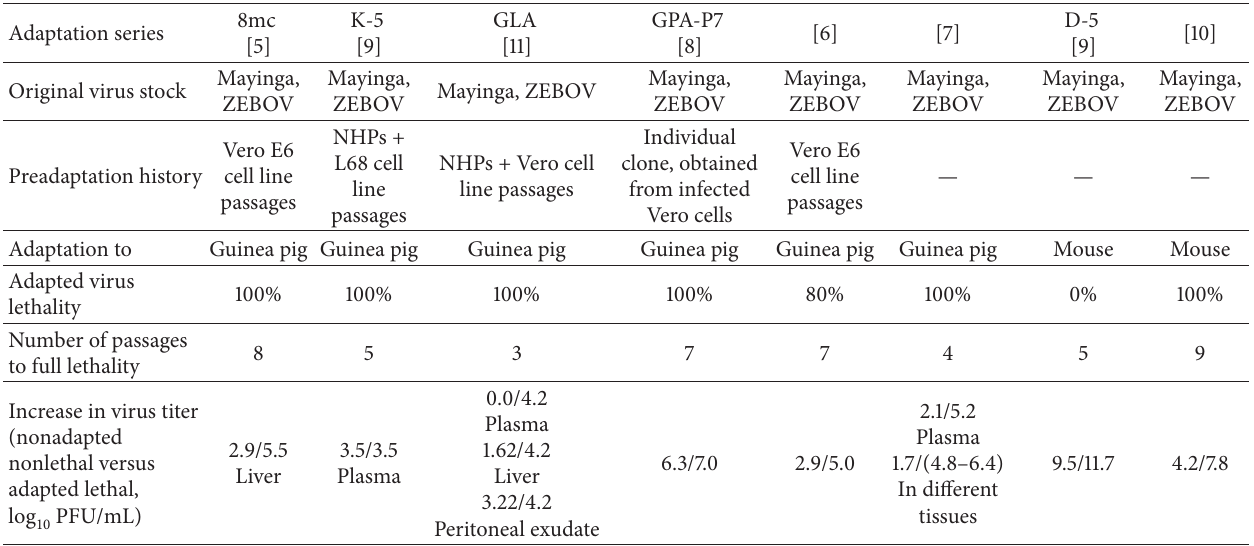
Table 1: Comparison of lethality, virus reproduction, and the time to adaptation (# of passages) in different adaptation series.